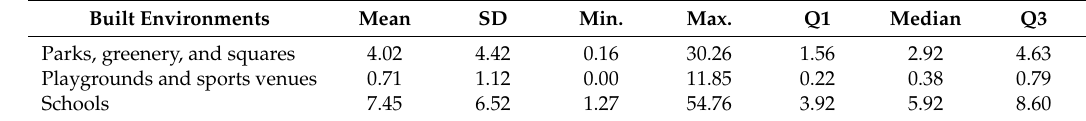
Table 3. Descriptive statistics of the built environment in the study townships ( n = 161). Built Environments Mean SD Min. Max. Q1 Median Q3 Parks, greenery, and squares